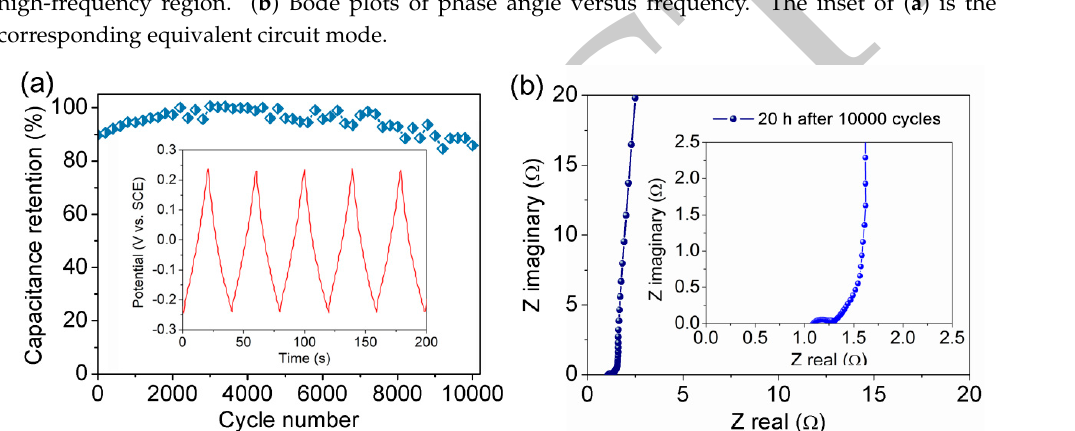
Figure 9. ( a ) Nyquist impedance spectra of different Ti 3 C 2 T x -based electrodes in magnified high- frequency region. ( b ) Bode plots of phase angle versus frequency. The inset of ( a ) is the corresponding equivalent circuit mode.